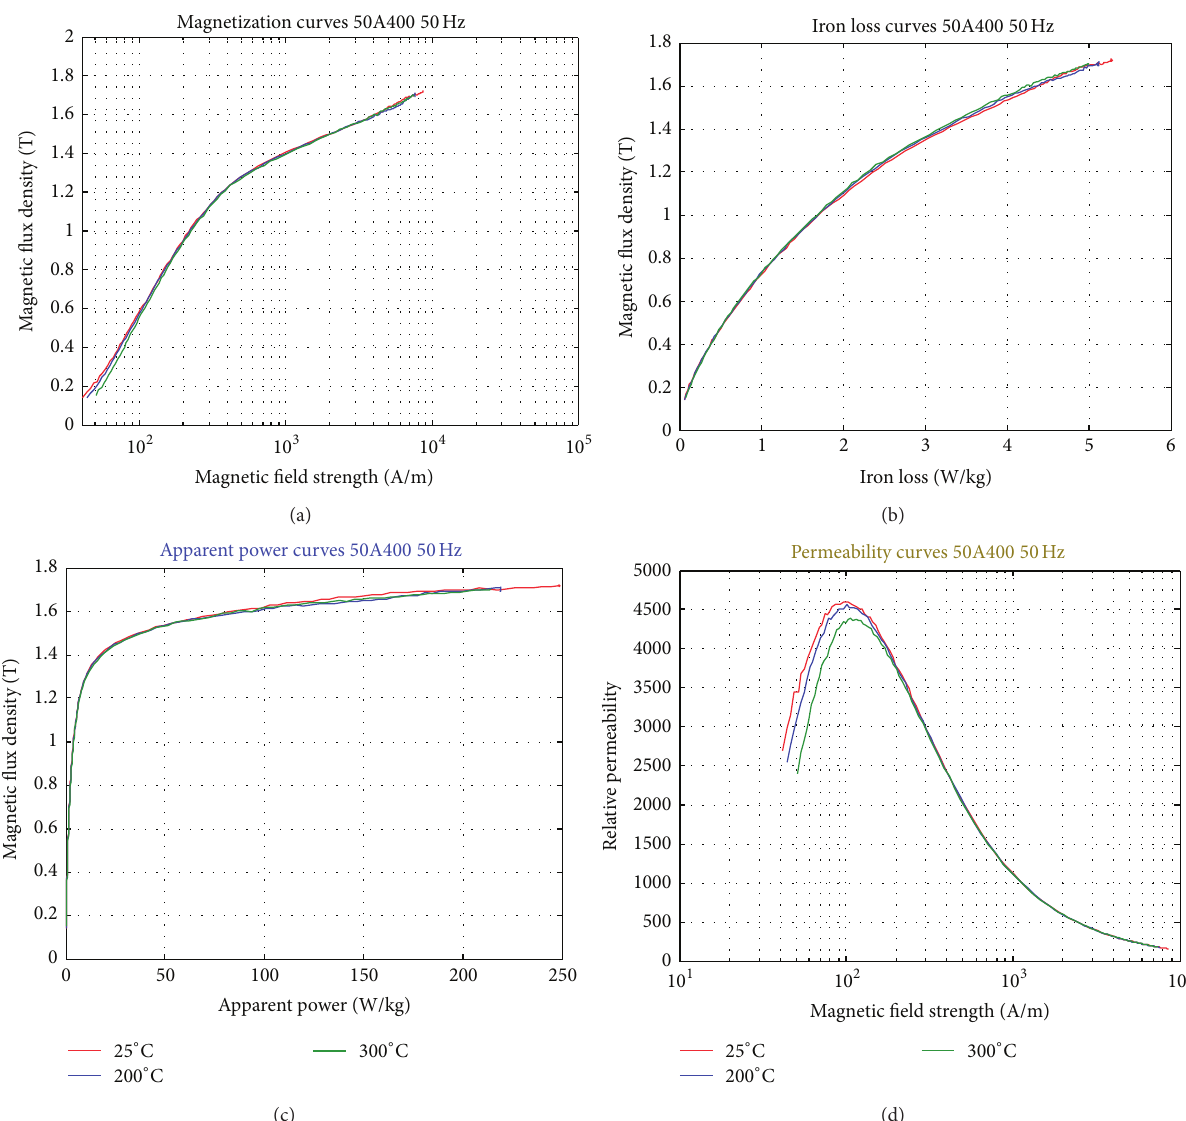
Figure 15: Magnetic properties measurement results obtained at different temperature. (a) Magnetization Curves. (b) Iron loss Curves. (c) Apparent power Curves. (d) Relative permeability